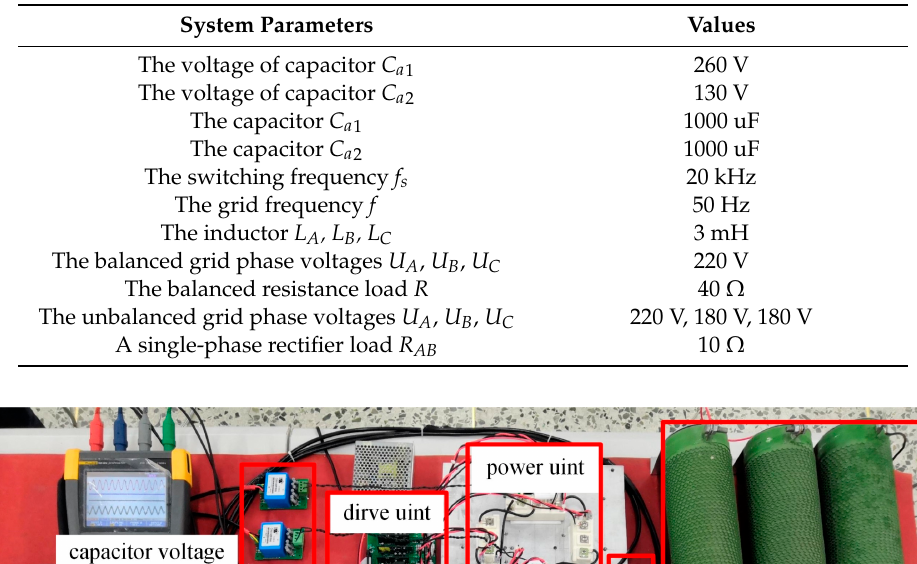
Table 4. Main parameters of the system.